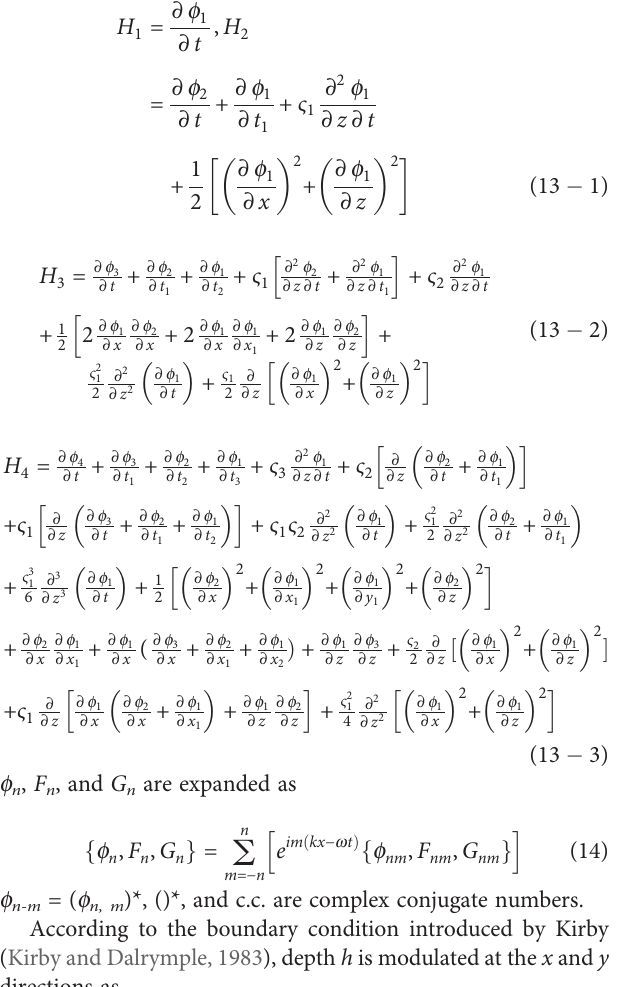
f f * , () * , and c.c. are complex conjugate numbers. n-m = ( n, m ) According to the boundary condition introduced by Kirby (Kirby and Dalrymple, 1983), depth h is modulated at the x and y directions as